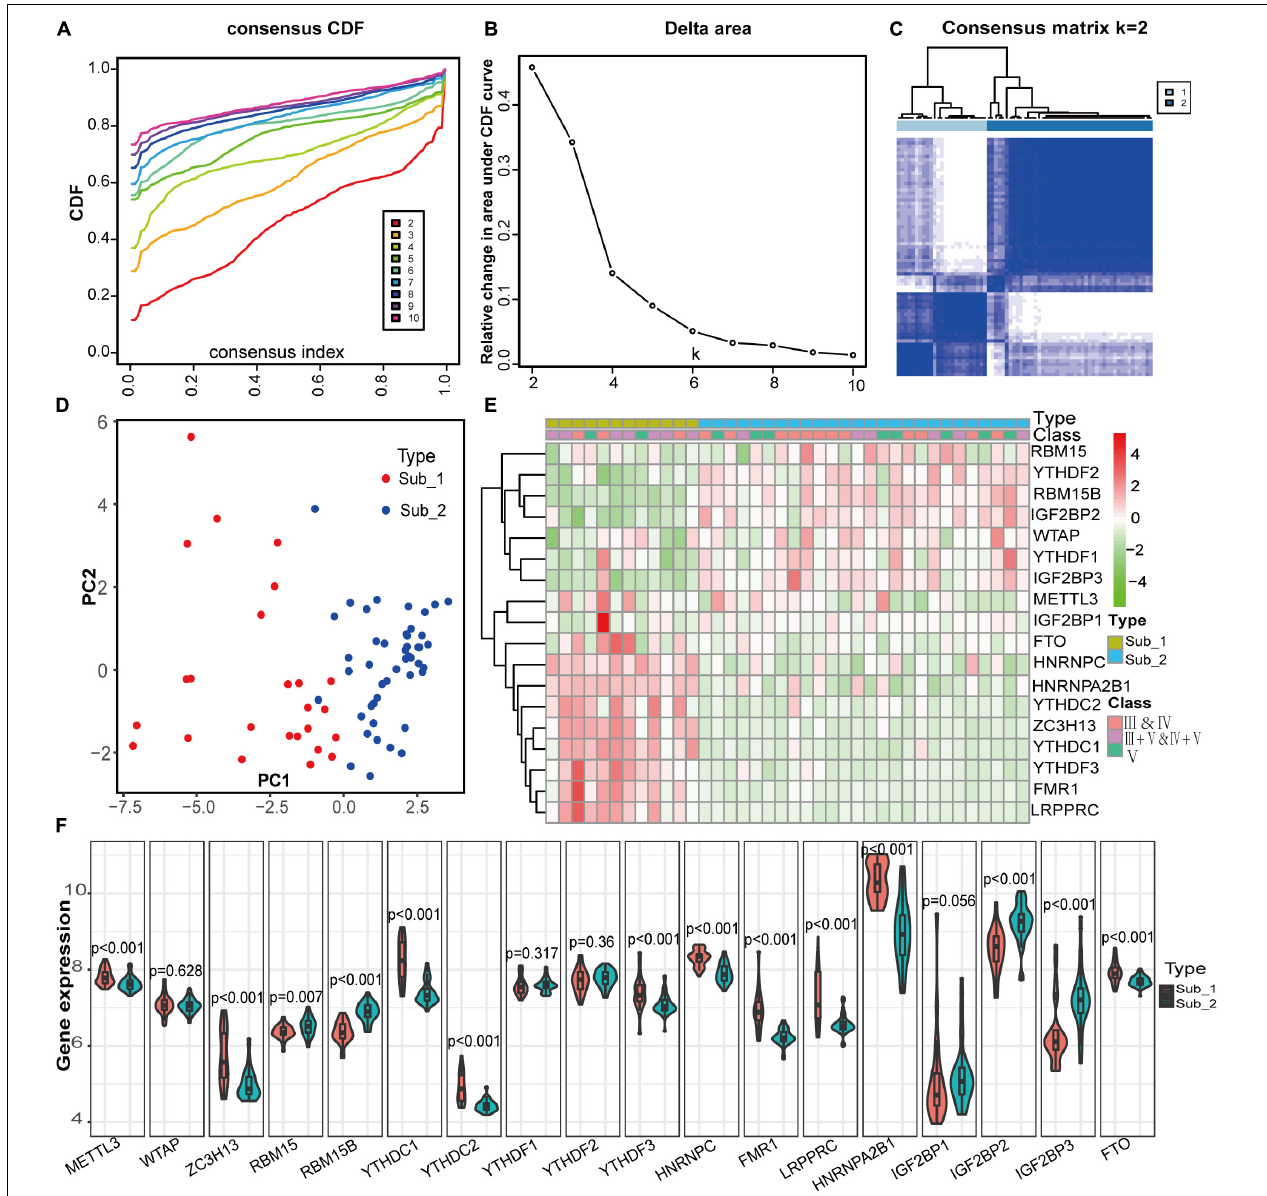
FIGURE 5 | Identification of two distinct m 6 A modification subtypes in LN and clinical correlation of two subtypes. (A) Consensus clustering of cumulative distribution function (CDF) for k = 2–9. (B) Elbow plot shows relative change in area under CDF curve. (C) Consensus clustering matrix for k = 2. (D) Principal component analysis (PCA) of two m 6 A subtypes in LN. (E) Heatmap of the clinical features of two clusters comparing the stages of LN and gene profiles between m 6 A subtypes in GSE127797. (F) The two m 6 A subtypes exhibit distinct expression statuses of 18 m 6 A RNA methylation